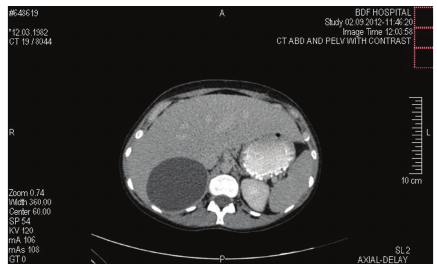
Figure 1: CT abdomen and pelvis showing the cyst.